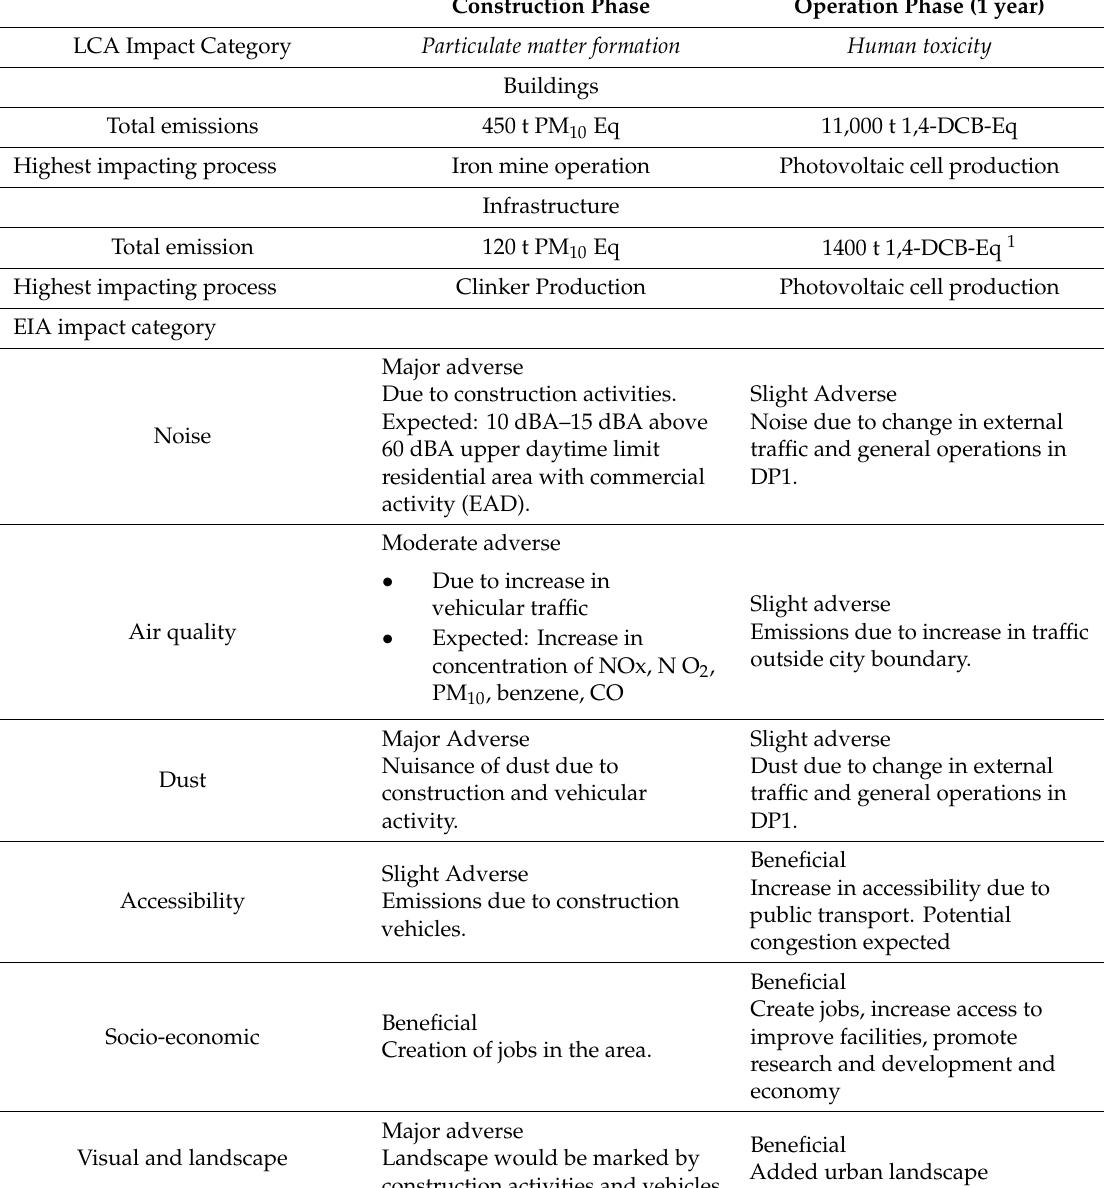
Table 4. On-site and o ff -site impact of the first development phase (DP1) on human